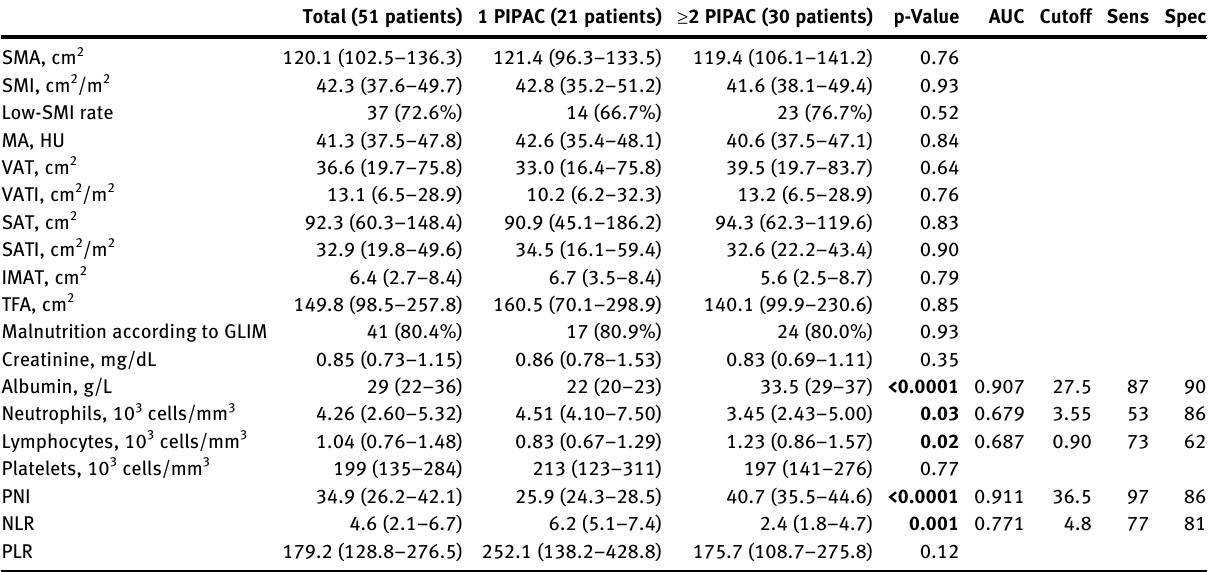
Table  : Multiple PIPAC procedures